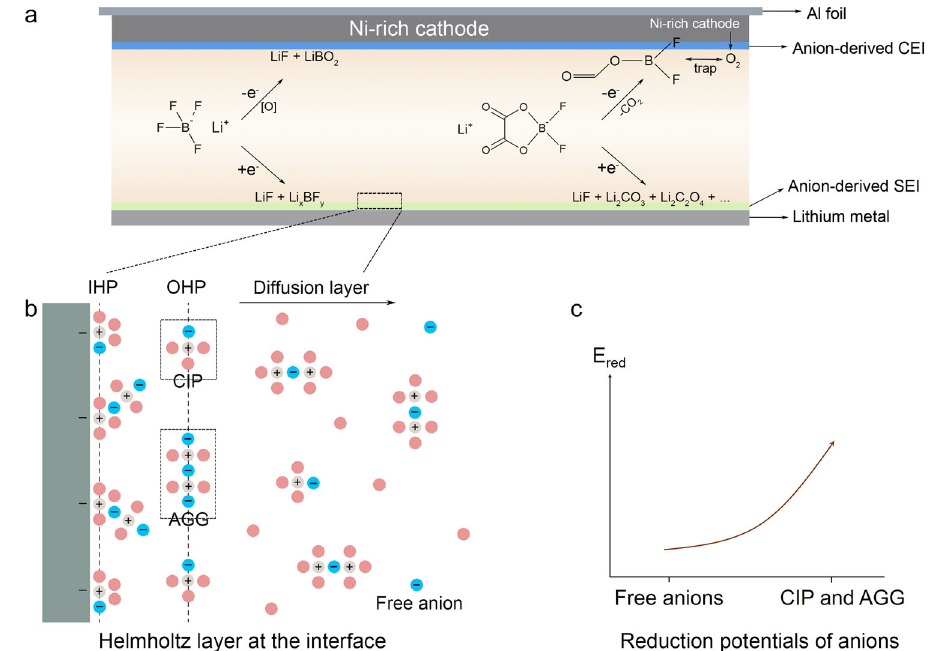
Fig.1|Designprincipleoftheanion-enrichmentinterface. Schematicillustration of a anion-enrichment interface and anion-derived EEIs and b electrode interface including innerHelmholtz plane(IHP), outerHelmholtzplane (OHP),anddiffusion layer.CEIandSEIrefertothecathodeandsolid-electrolyteinterphase,respectively.